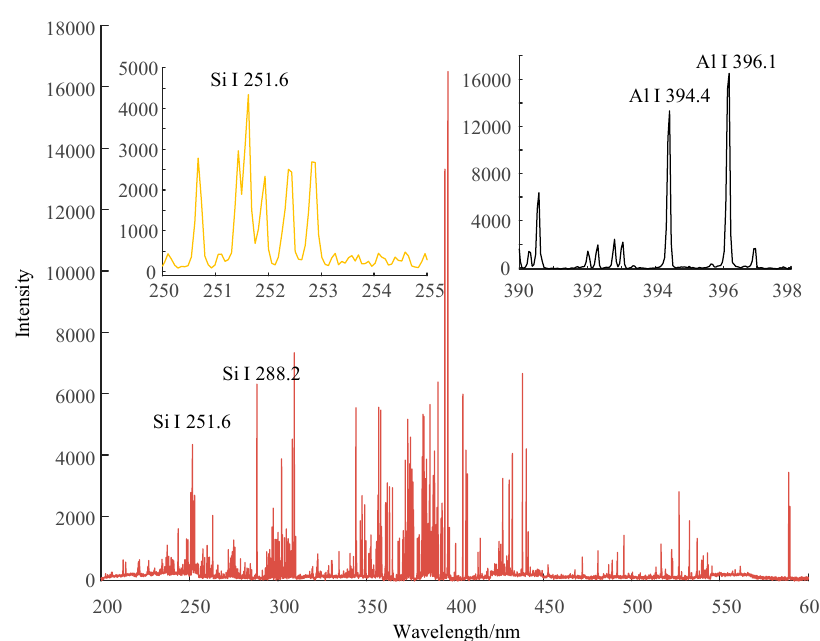
Figure 7. Emission spectrum of new silicone rubber with no silica filler, while the mass fraction of ATH is 1.5.